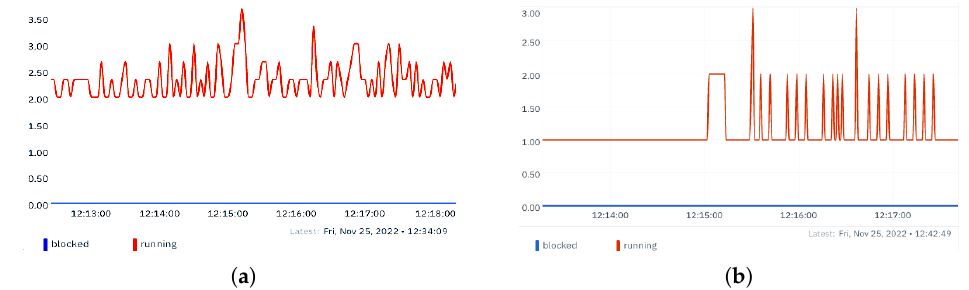
Figure 12. Consumption of the system processes on devices ( a ) Jetson, and ( b ) Raspberry Pi, at time 12:15 (y → average system processes and x →